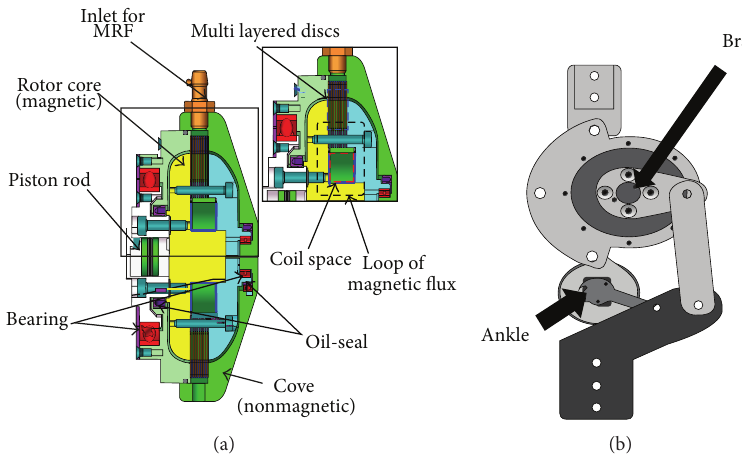
Figure 7: (a) Schematic of MR brake cross section of MR brake, (b) linkage mechanism [41].